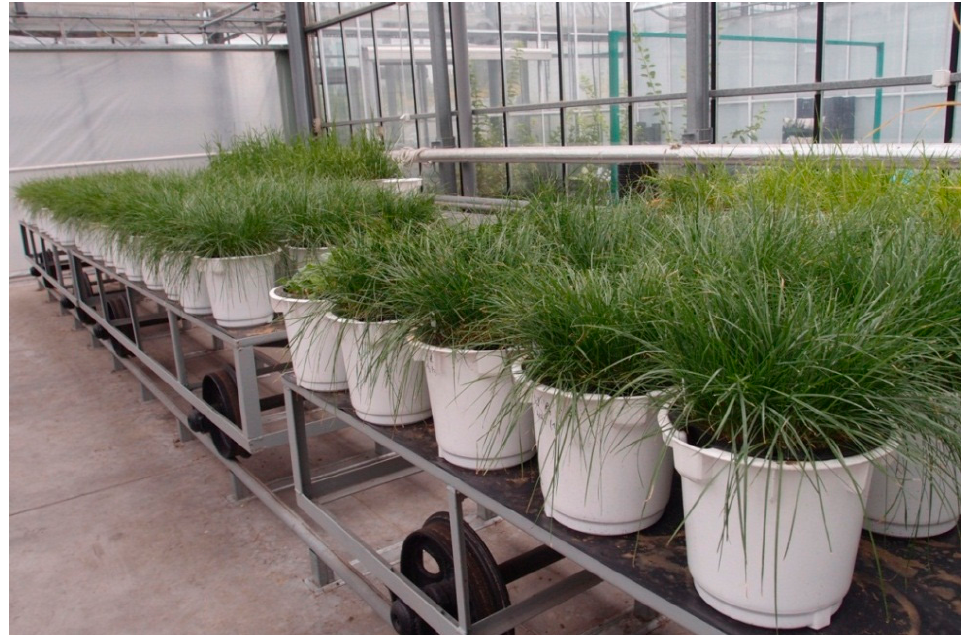
Figure 1. Pot experiment settled in May 2011 in vegetation hall of Plant Physiology Department SGGW in Warsaw.